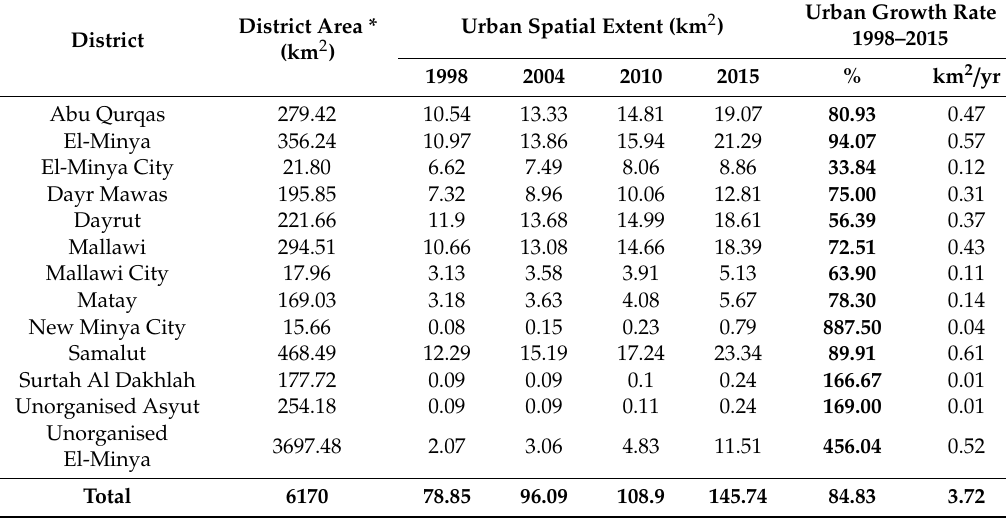
Table 6. Urban spatial extent (km 2 ) within the di ff erent analysed districts in Middle Egypt for four time periods, and urban growth rates (% and km 2 / yr) for the period 1998–2015 (total size of the study area equals 6170 km 2 ).